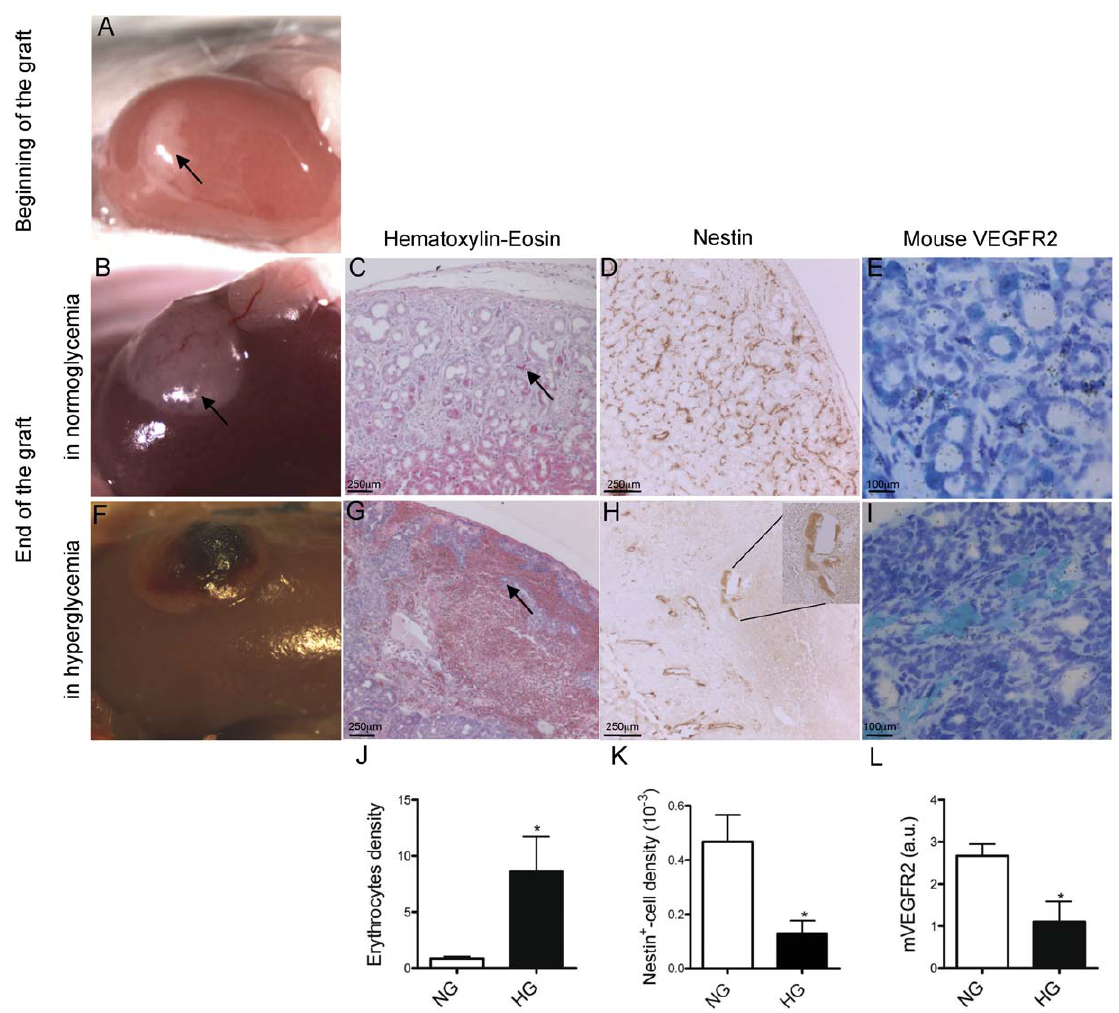
Figure 2. Graft of embryonic chick pancreas under SCID mouse kidney capsule. At 14 dpi embryonic chick pancreas (A) was grafted under the kidney capsule of a normoglycaemic SCID mouse and analyzed 2 weeks post-transplantation (B). At that time, hematoxylin-eosin coloration (C) enabled us to observe many vessels filled with erythrocytes (arrow). Immunohistochemistry for nestin (D) and in situ hybridization for mouse VEGFR2 probe (E) indicated the murine origin of endothelial cells in the pancreatic graft. In hyperglycaemic conditions (F–I), dark spots were present on the top of the pancreatic grafts (F). Vascularization was disorganized with large blood-fill spaces (G, arrow) associated with vessel discontinuities (H, insert). Morphometry analyses of erythrocytes staining (G), nestin immunohistochemistry (H) and mouse VEGFR2 in situ hybridization (I) showed a decreased number of endothelial cells (J, K and L). Student t- test *p , 0.05, n=4–6.